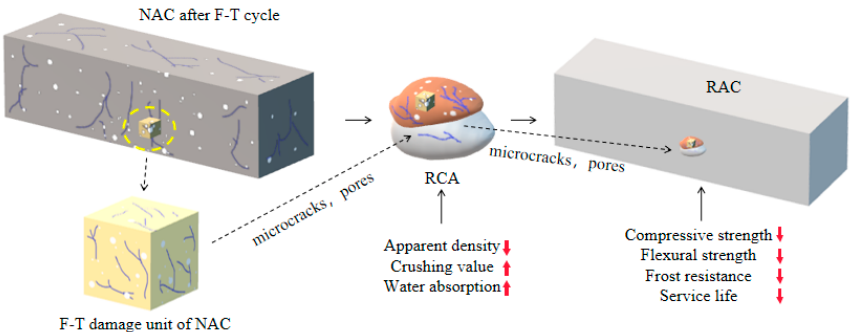
Figure 14. Effect mechanism of NAC F-T damage on properties of RAC.